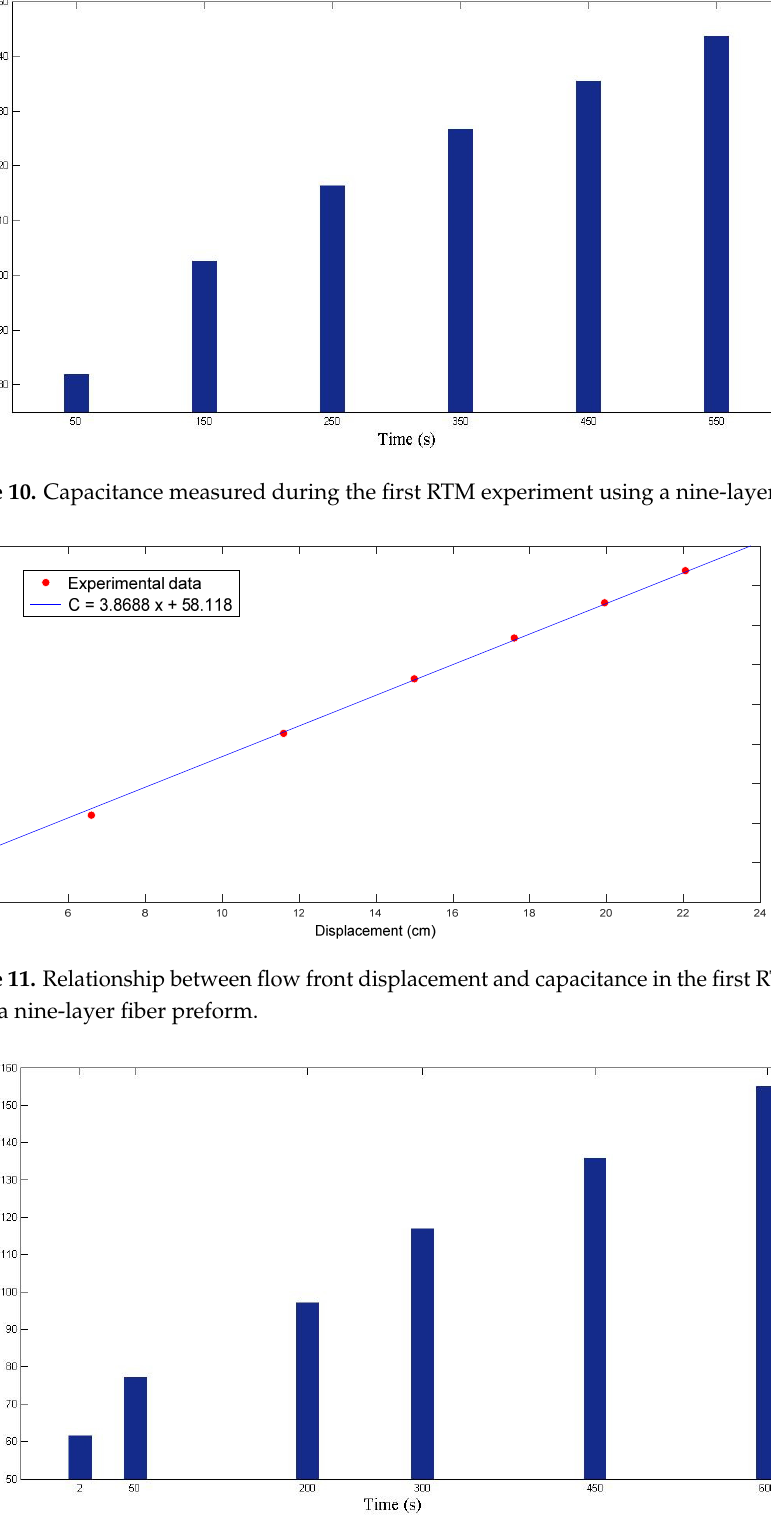
Figure 13. Relationship between flow front displacement and capacitance in the second RTM exper- iment using a nine-layer fiber preform . Following a similar procedure to that introduced in the previous paragraph, it was calculated that 𝑉 (cid:3033) = 0.233, 𝜙 = 1 − 𝑉 (cid:3033) = 0.767 , and 𝐾 = 2.07 × 10 (cid:2879)(cid:2869)(cid:2868) m (cid:2870) . Such results are close to those obtained in the previous experiment. 4.2. Experiments on Seven-Layer Fiber Preforms The fiber preforms used in the second case study were constructed with seven layers of glass fiber sheets. The fiber sheets used in this case study were purchased in a different batch from those used in the case study described in Section 4.1. Therefore, although the weave patterns of fibers were similar, there was still a certain degree of differences in material properties. The images captured by the visualization system are shown in Figure 14, from which the flow front displacements can be identified. The changes of capacitance are plotted in Figure 15. Combining the information recorded by both the visualization system and the capacitance sensor, the relationship between x and C can be estimated. As shown in Figure 16, the regression function is 𝐶 = 4.4579𝑥 + 67.603